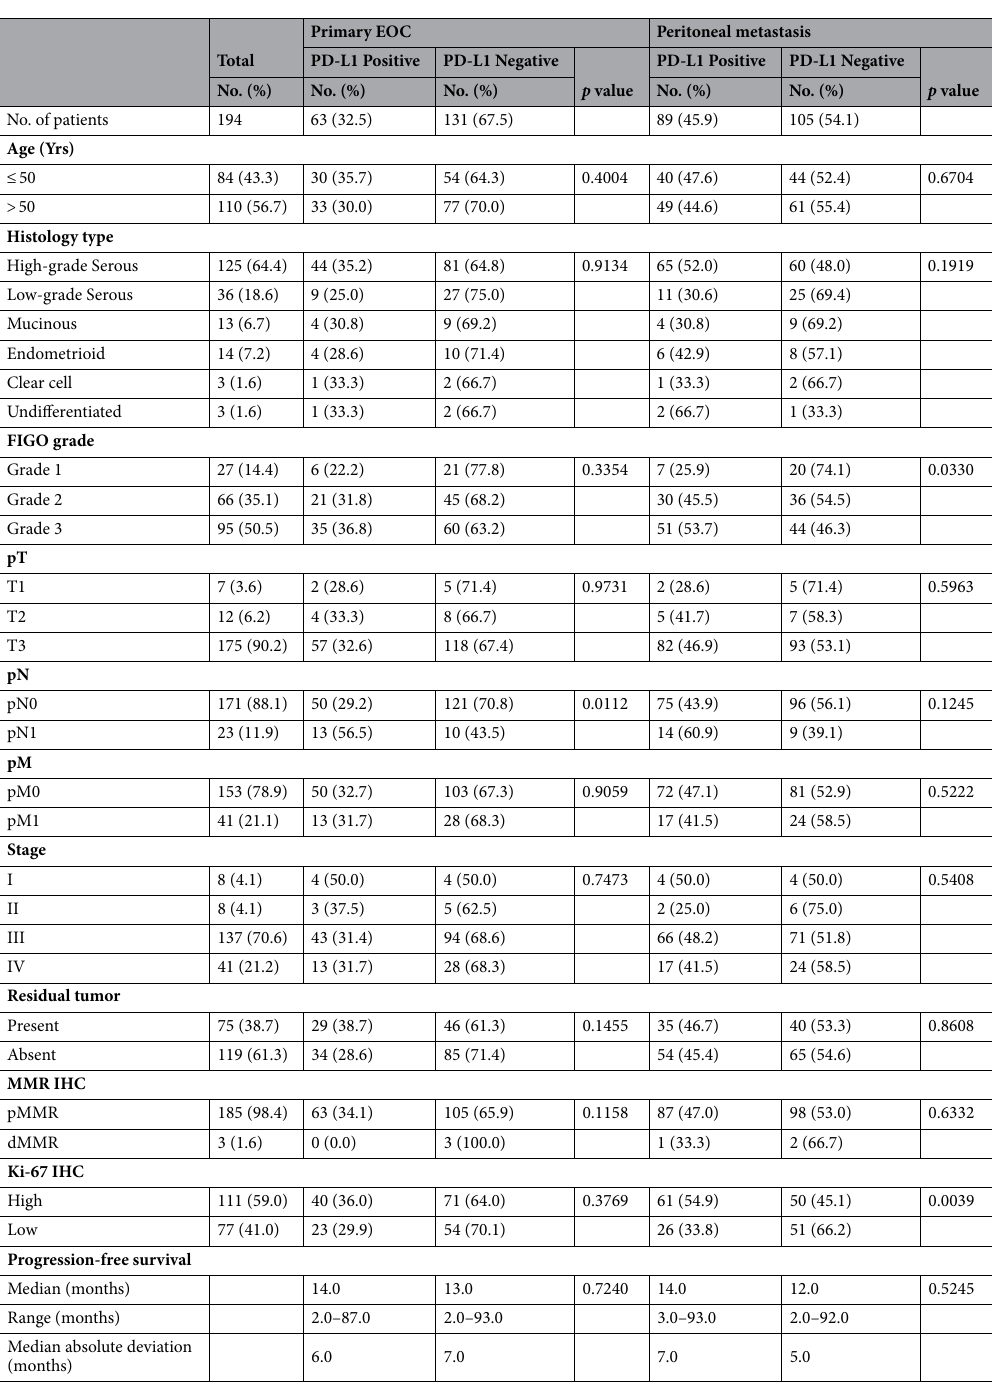
Table 3. Clinico-pathological associations of PD-L1 protein expression in primary EOC and corresponding peritoneal metastasis. MMR mismatch repair, pMMR proficient MMR, dMMR deficient